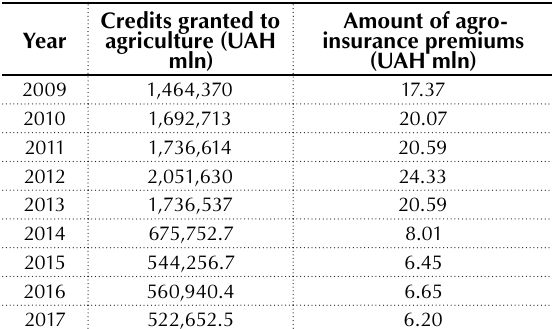
Table 4. Simulated values of non-state financing of Ukrainian agriculture in terms of sector lending and agro-insurance